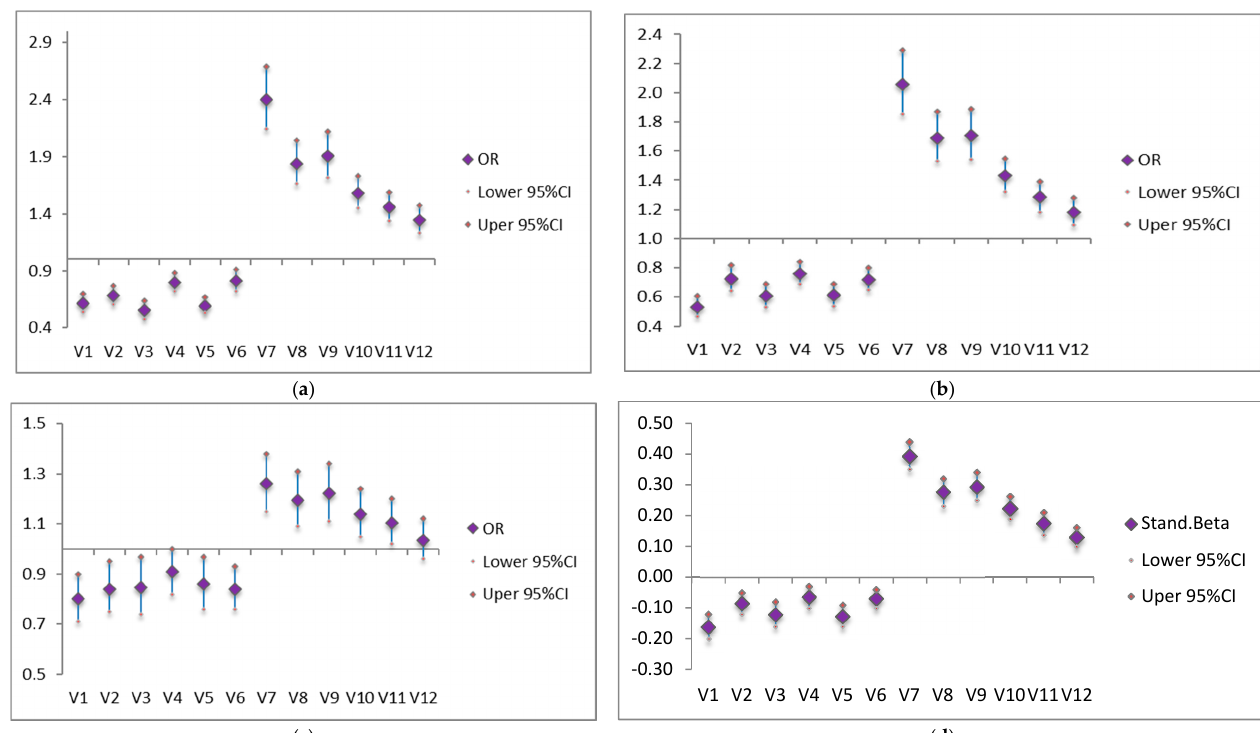
Figure 1. The relationship between coping behavior and Post-Traumatic Stress Symptoms (PTSS), depression, insomnia, mental health problems. ( a ) coping and PTSS, ( b ) coping and depression, ( c ) coping and Insomnia, and ( d ) coping and mental health score. Notes: V1 refers to “tell myself that everything will be better